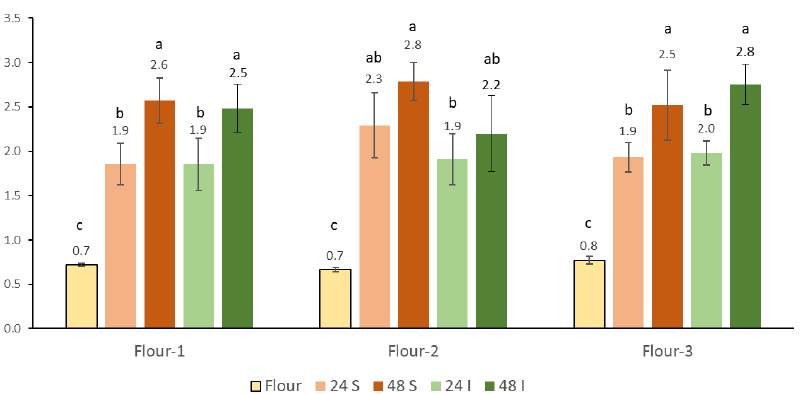
Figure 3. Influence of fermentation on the accumulation of antioxidants in three chickpea sour- doughs from Flour-1, Flour-2, and Flour-3 prepared by spontaneous fermentation (S) and inocu- lated fermentation with commercially available starter (I) after 24 h and 48 h of fermentation at 30 °C. Values marked with a different letter (a, b, c) differ significantly in antioxidant content for a particular flour and sourdoughs prepared from that flour. The differences were significant at the p < 0.05